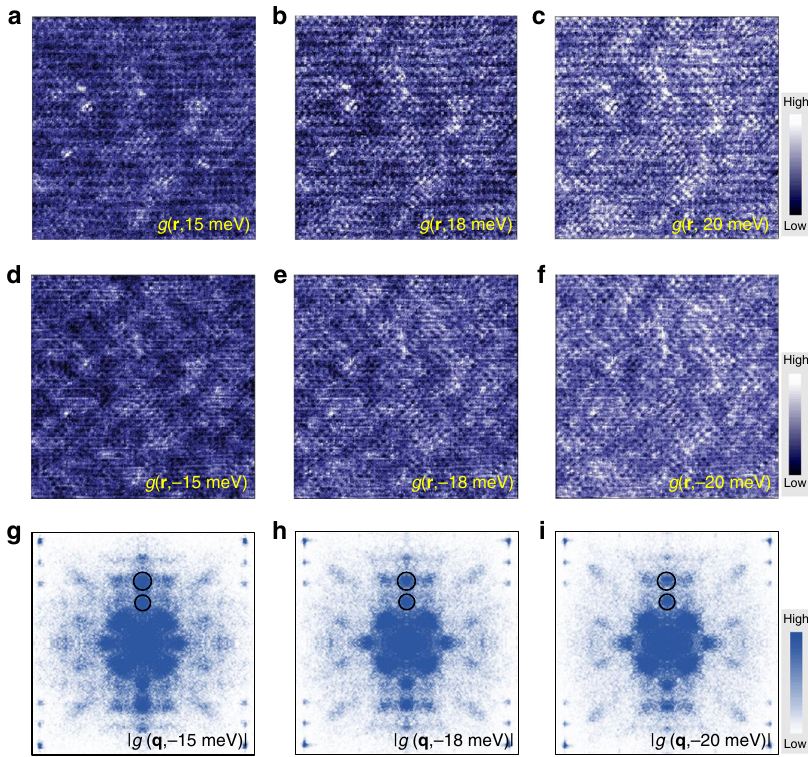
Fig. 3 QPI and FT-QPI patterns measured on Bi-2212. a – f Differential conductance mappings at different energies. g – i Three corresponding FT-QPI patterns of d – f , respectively. The supermodulations contribute to the FT-QPI intensity surrounded by the solid-line circles, and these spots seem to have very weak